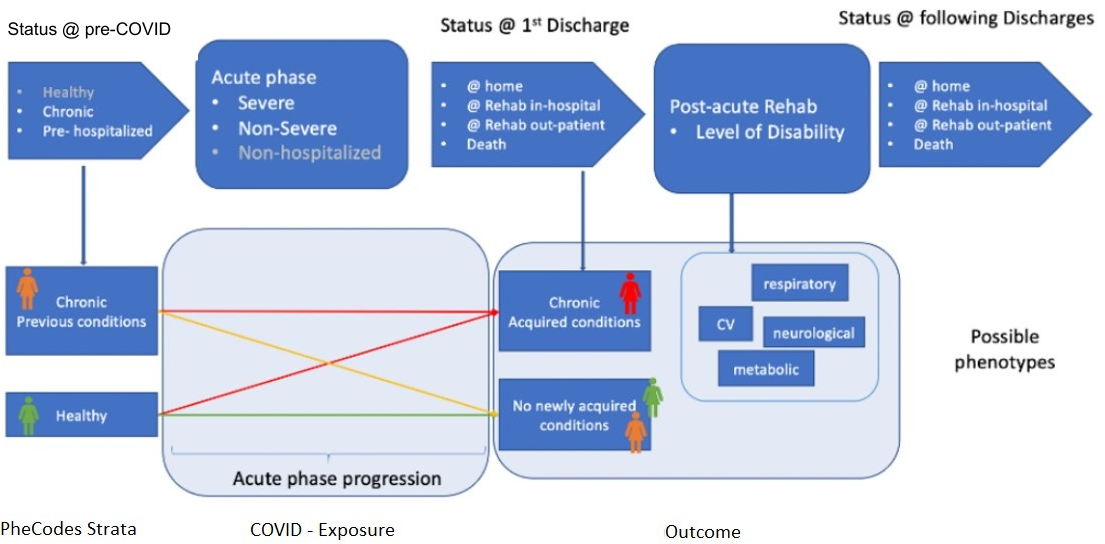
Figure 1. Scheme of the 4CE process that can be used to predict clinical patterns and identify subgroups of patients.